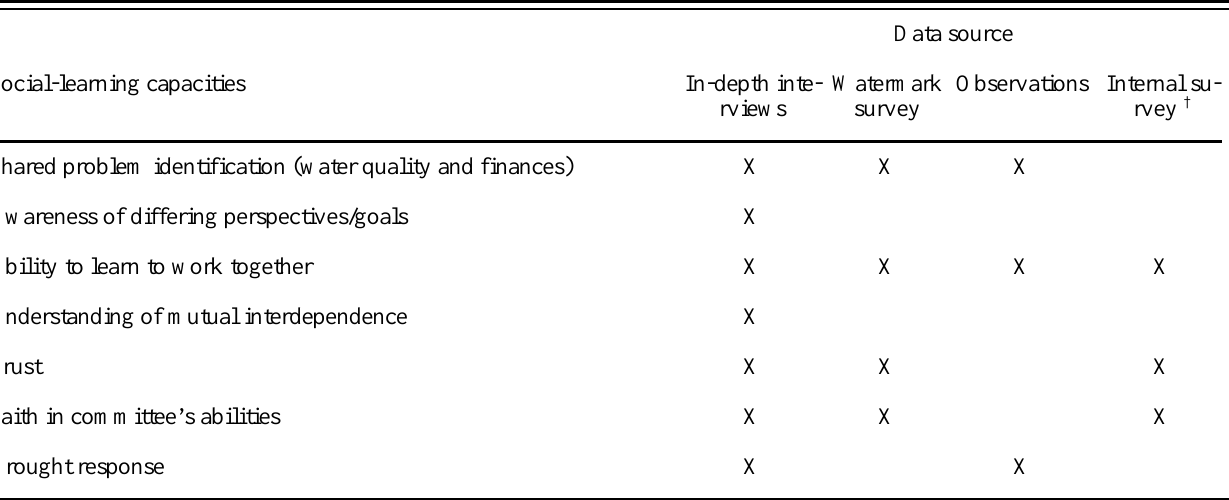
Table 1. Social-learning elements identified within CEIVAP by data